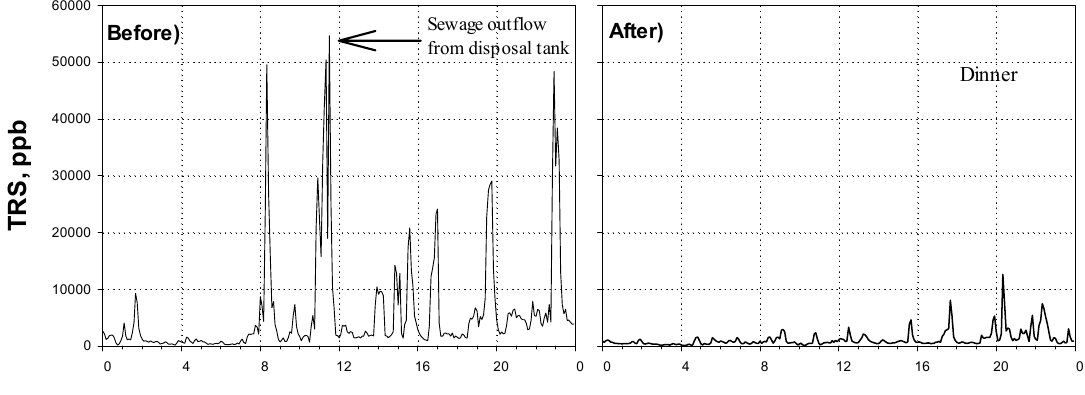
Figure 5. Time profiles of TRS measured at District-FIVE before and after application of